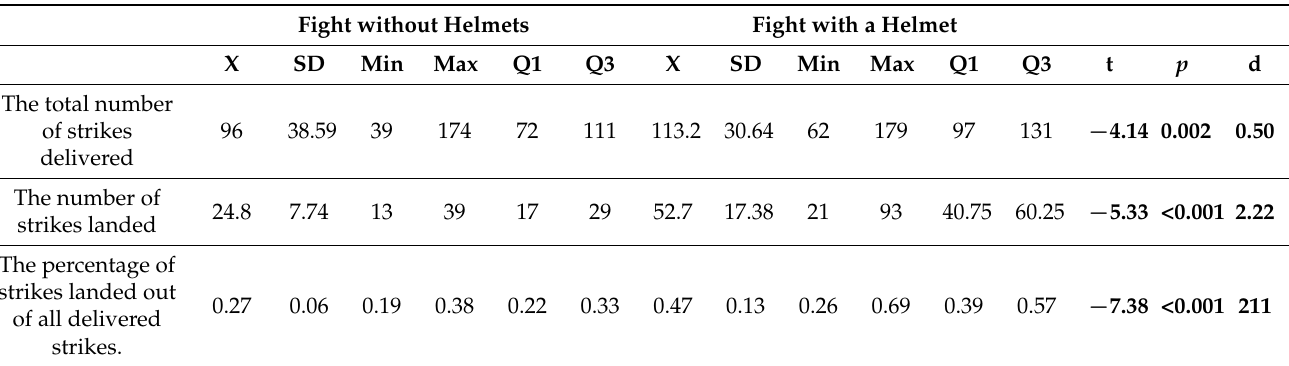
Table 2. Descriptive and comparative statistics of fights with and without a helmet in relation to hand and foot techniques.